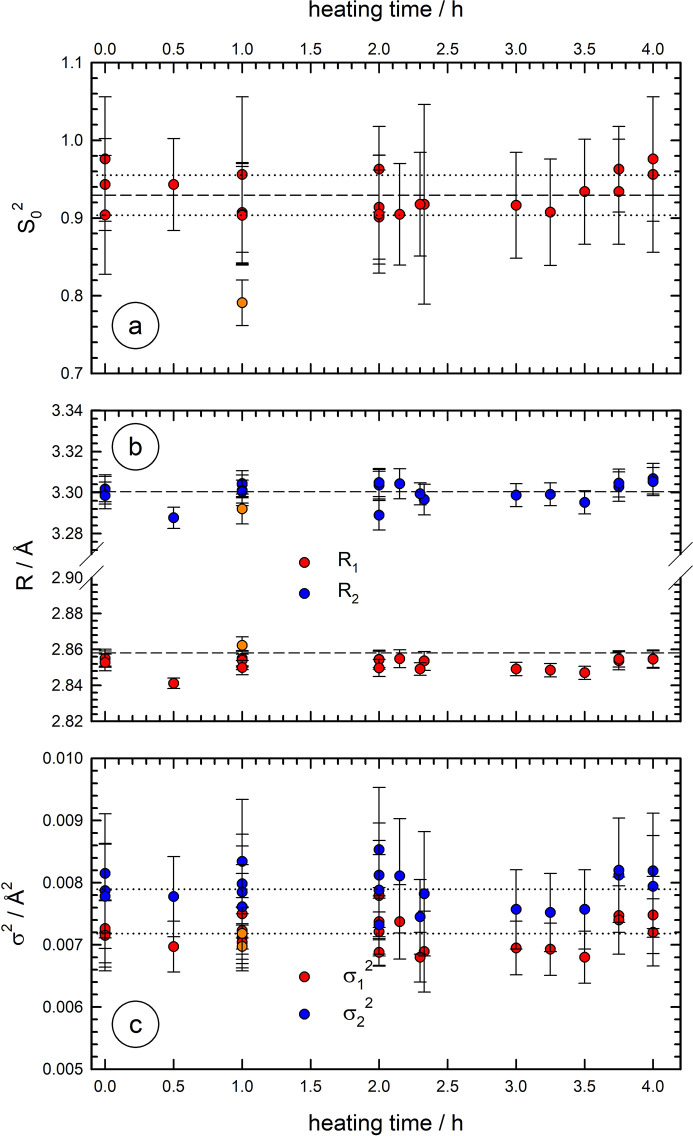
Results of an EXAFS data fitting procedure of Nb foils heat-treated in vacuum as a function of the heating time at 900°C. For the experiments, the samples were cooled to room temperature under high vacuum prior to the measurements. (a) Plot of the amplitude reduction factor ; the dashed and the dotted lines represent the average  and its confidence interval. (b) The distances of the first two Nb–Nb coordination shells (R
1, R
2) in comparison with their literature values (dashed lines) and (c) their mean-squared displacements (, ) with average values (dotted lines). The orange data points belong to the sample heat-treated in the commercial high-temperature cell. See text for more details.